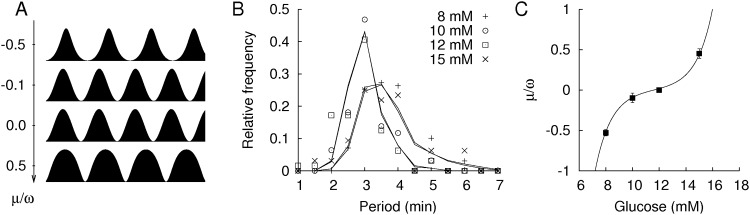
Phase modulation and periods of Ca2+ oscillations.(A) Phase modulated oscillations of the active rotator model. (B) Distributions of the dominant periods of Ca2+ oscillations under 8 mM (‘+’ symbol, n = 99), 10 mM (circle, n = 94), 12 mM (square, n = 64), and 15 mM (‘×’ symbol, n = 64) glucose. The symbols represent data, and the solid lines represent the model predictions. The predicted distributions are too close to distinguish for 8 mM and 15 mM glucose and for 10 mM and 12 mM glucose. (C) Phase modulation depending on glucose concentrations. The symbols represent estimated values and their standard deviations, and the solid line represents the nonlinear function μ(G).